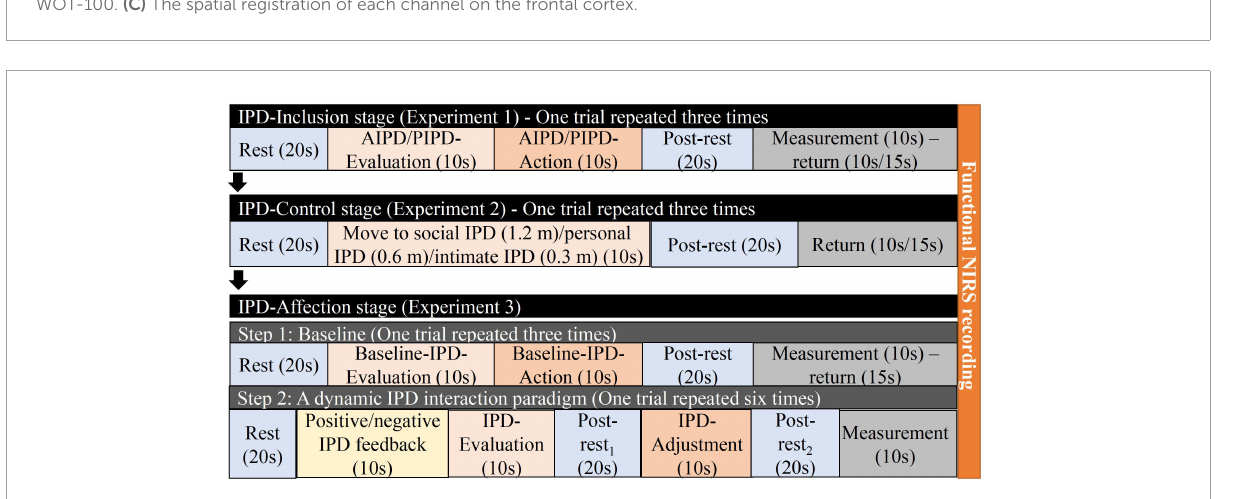
FIGURE2 Experiment procedures for differing social status IPD interactions. Procedures from experiment 1, experiment 2, and experiment